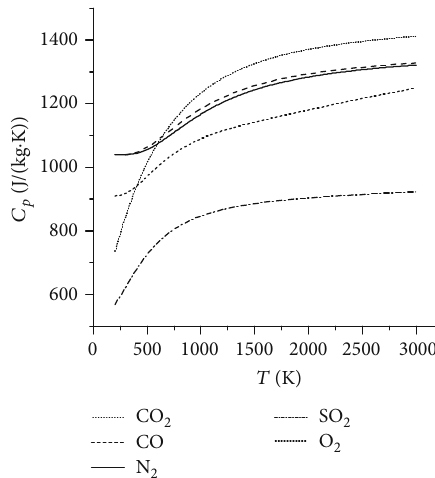
Figure 1: Speci fi c heat as a function of